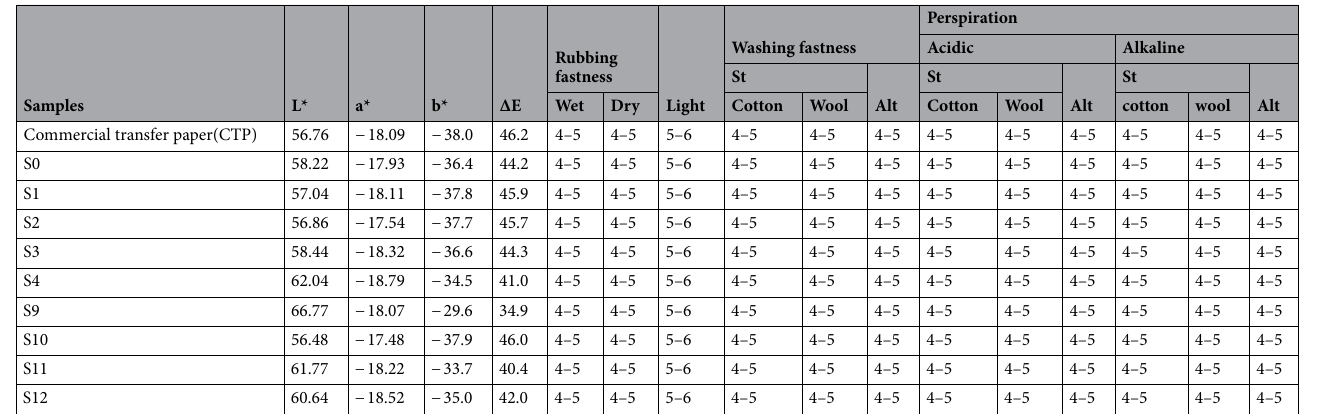
Table 7. The colour parameters and fastness properties of transfer printed polyester fabrics using modified screen-printed papers at 210 °C and 60